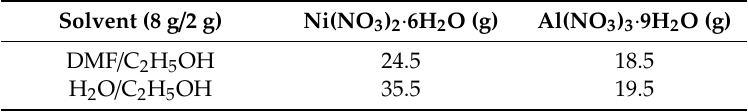
Figure 1. XRD patterns of the catalysts with different solvents: ( a ) Before reduction; ( b ) after reduction at 750 °C for 1 h. Table 1. Solubility of nitrates in two solvents.